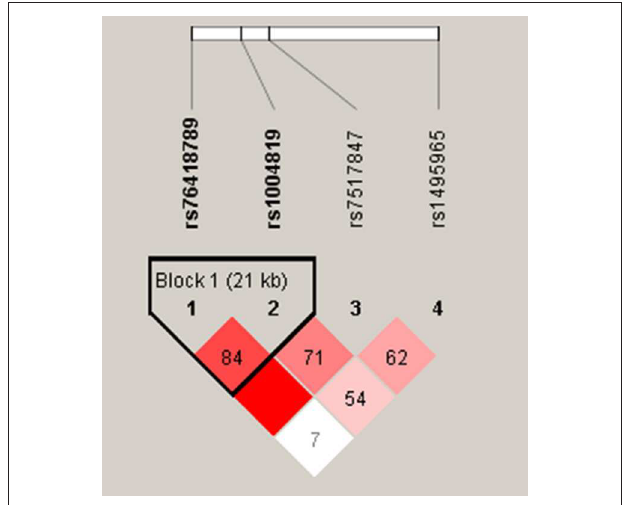
FIGURE 1 | Linkage disequilibrium (LD) and haplotype block structures of IL23R. Single nucleotide polymorphisms, rs76418789 (G149R) and rs1004819, in tight LD were organized in a single haplotype